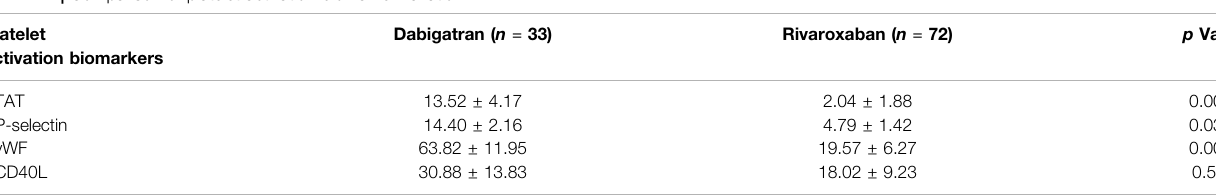
TABLE 2 | Comparison of platelet activation biomarker variation. Platelet activation